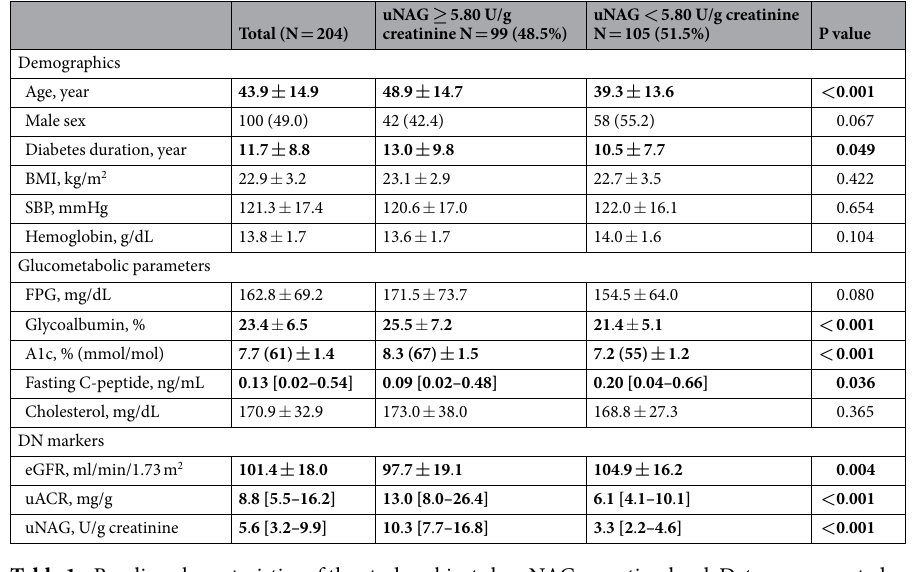
Table 1. Baseline characteristics of the study subjects by uNAG excretion level. Data are presented as mean ± standard deviation, median [interquartile range], or as numbers (%). Bold characters represent statistically significant values. Abbreviations: A1c, hemoglobin A1c; BMI, body mass index; SBP, systolic blood pressure; FPG, fasting plasma glucose; DN, diabetic nephropathy; uNAG, urinary N-acetyl- β -D- glucosaminidase to creatinine ratio; eGFR, estimated glomerular filtration rate; uACR, urinary albumin-to- creatinine